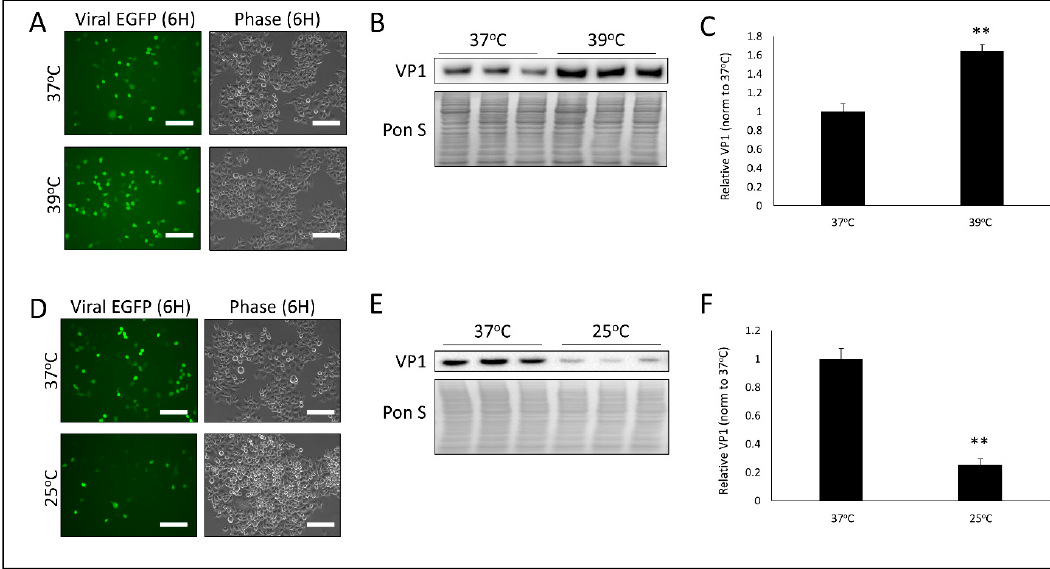
Figure 1. Temperature significantly alters CVB infection- HeLa human cervical cancer cells were kept at either 37 °C, 39 °C or 25 °C for 24 h. Cells were then all incubated at 37 °C for 30 min and infected with enhanced green fluorescent protein coxsackievirus B (EGFP-CVB) at multiplicity of infection of 1 (MOI 1) for 6 h. ( A ) Fluorescence microscopy compares viral EGFP expression between cells kept at either 37 °C or 39 °C. Phase contrast images are shown to the right of respective fluorescence image fields. Scale bars represent 150 µm. ( B ) Western blot on cell lysates from A detecting VP1 viral capsid protein. Ponceau S is shown below. ( C ) Densitometric quantification of western blot in B. (** p < 0.01; Student’s t-test, n = 3). ( D ) Fluorescence microscopy comparing viral EGFP expression between cells kept at either 37°C or 25 °C. Phase contrast images of same field are shown to the right. Scale bars represent 150 µm. ( E ) Western blot on cell lysates from D detecting VP1 viral capsid protein. Ponceau S is shown below. ( F ) Densitometric quantification of western blot in E. (** p < 0.01; Student’s t-test, n = 3).